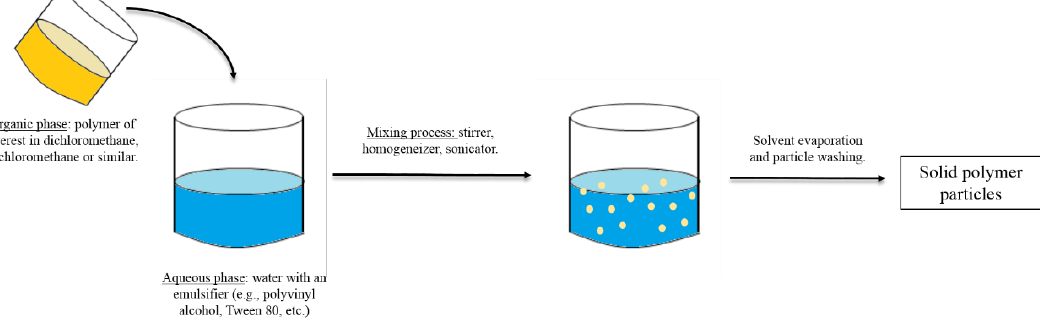
Figure 3. Schematic representation of the single emulsion-solvent evaporation method.